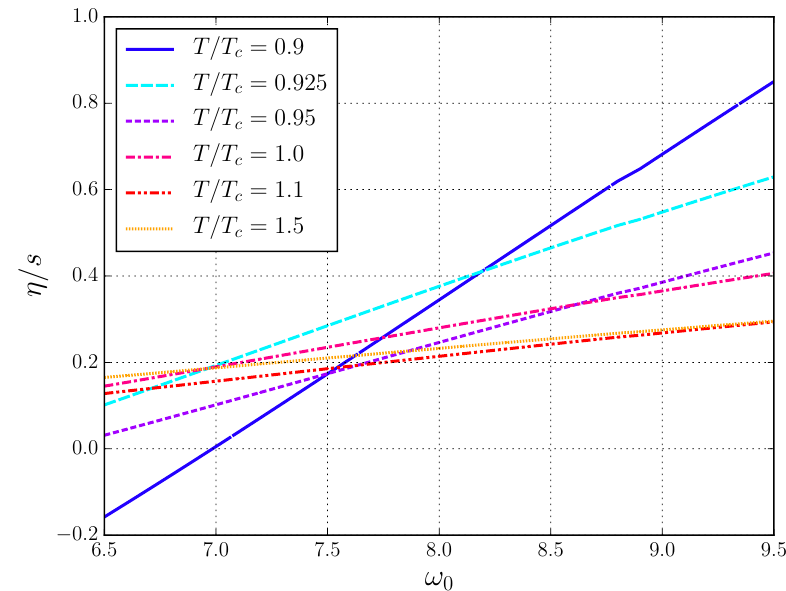
Figure 4 . The ratio (cid:17)=s with the ultraviolet contribution subtracted as a function of ! 0 for the temperatures T=T c = 0 : 9 ; 0 : 925 ; 0 : 95 ; 1 : 0 ; 1 : 1 ; 1 : 5. The parameter A is taken as the central value of the (cid:12)t of the lattice data by the function (cid:26) 3 ( !